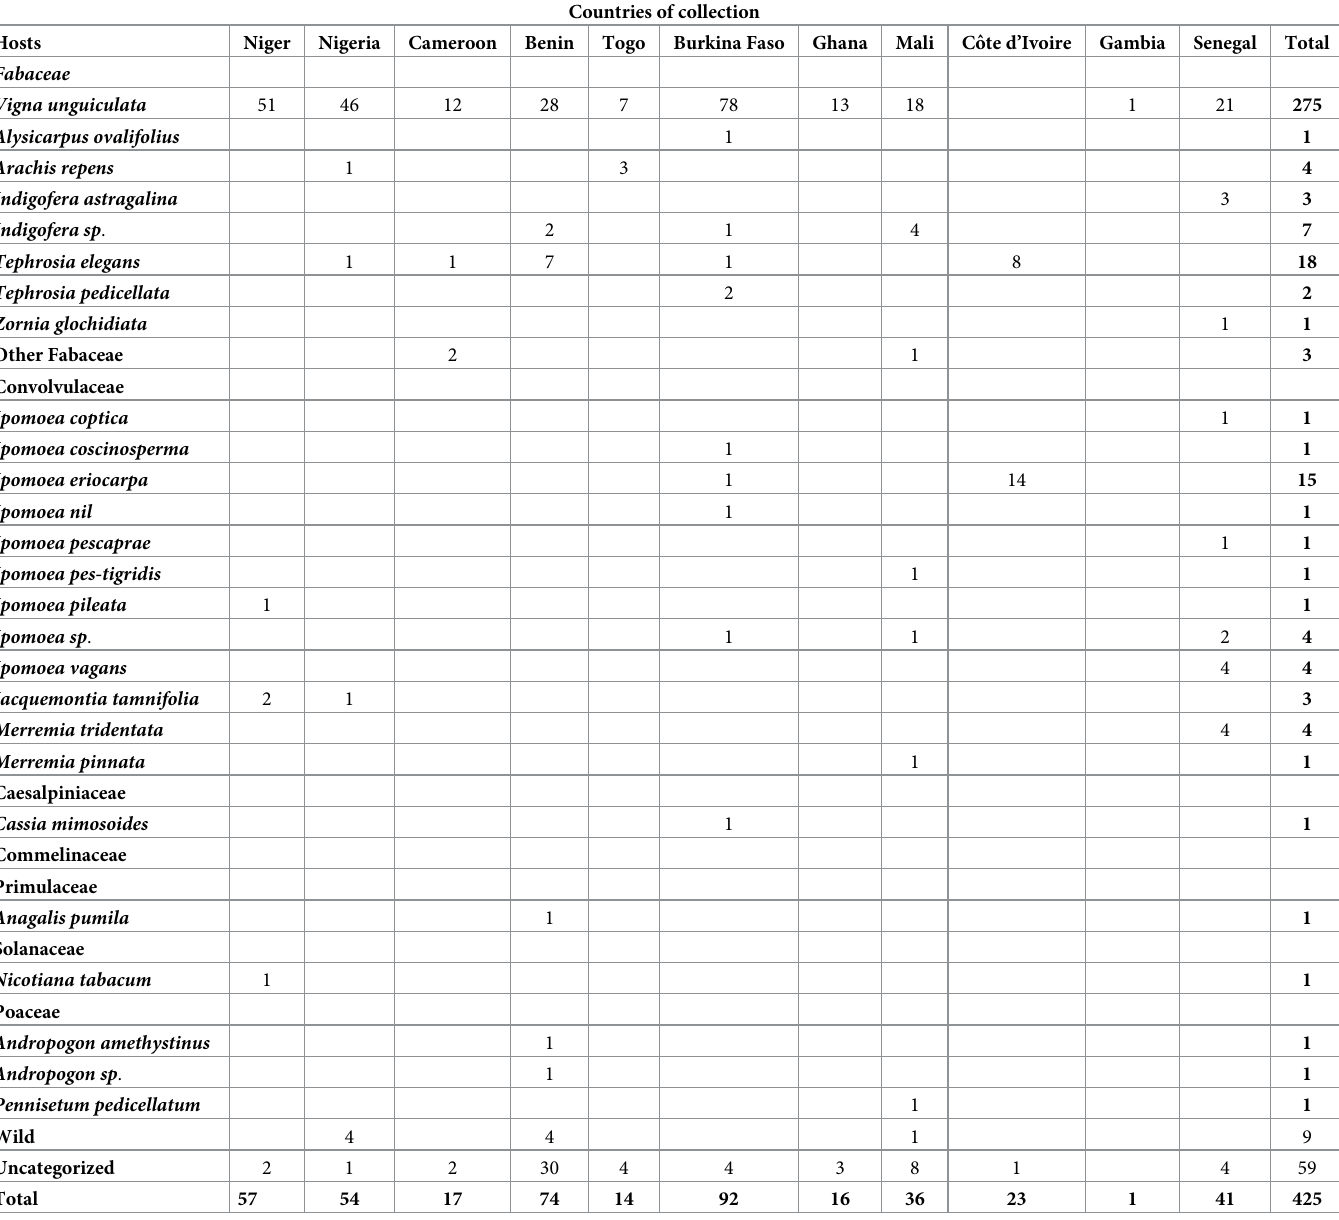
Table 2. Number of S . gesnerioides parasitism records per host and country in West Africa. There were no records for Guinea, Guinea Bissau, Liberia, and Sierra